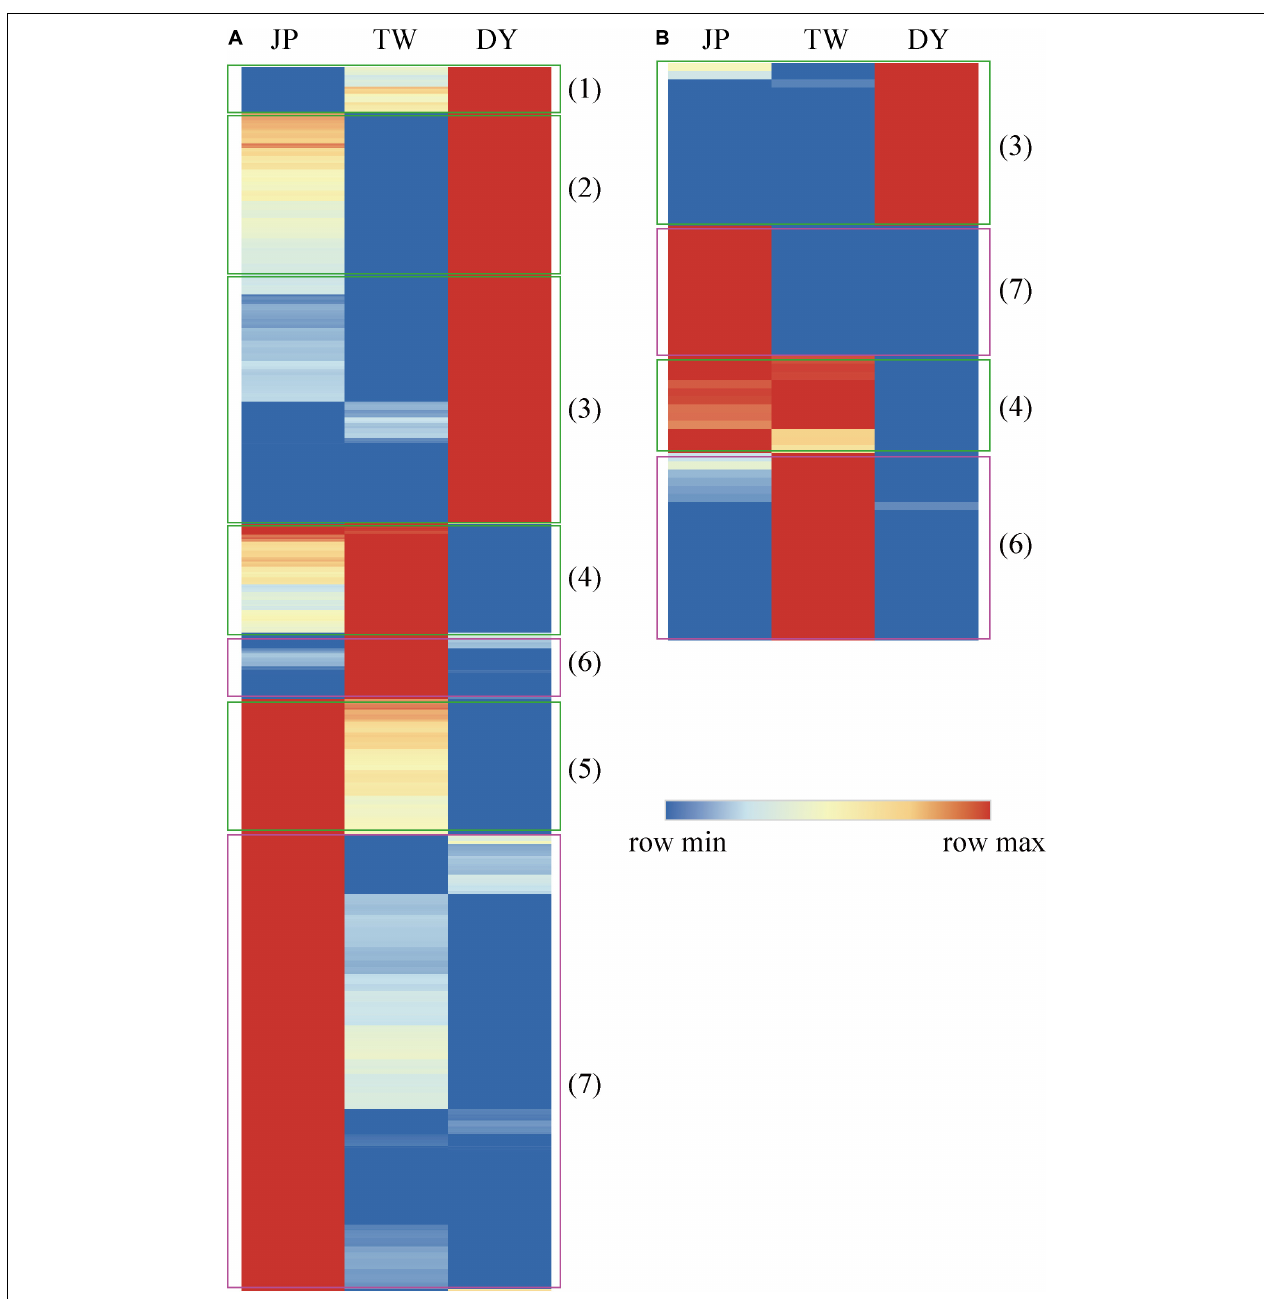
FIGURE 2 | Heatmap clustering of the (A) non-additively expressed genes and (B) non-additively expressed miRNAs between the three H. diversicolor genotypes. Relative gene expression levels in the three genotypes were normalized to the middle parental value MPV. Red and blue bars represent up- and down-regulated expression levels of individual gene, respectively. Green boxes indicate genes/miRNAs with overdominant or underdominant expression patterns: (1) “DY > TW > JP;” (2) “DY > JP > TW;” (3) “DY > JP = TW;” (4) “DY < JP < TW;” or “DY < JP = TW;” and (5) “DY < TW < JP.” Pink boxes indicate genes/miRNAs with dominant expression patterns: (6) “DY = JP < TW” and (7) “DY = TW < JP.”